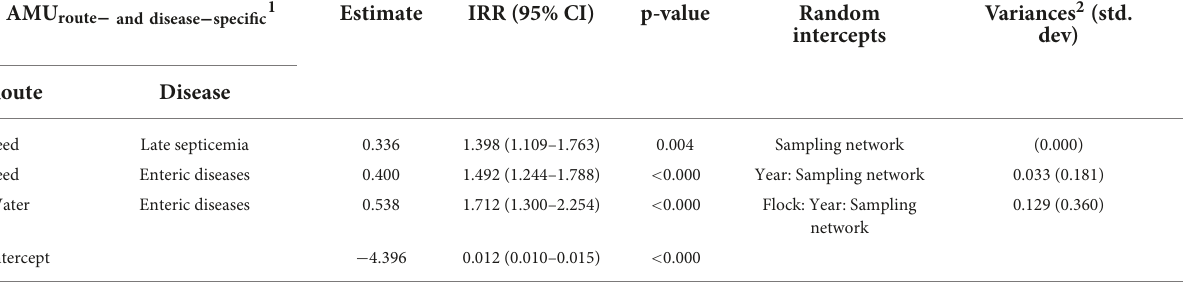
TABLE 4 Multivariable mixed-effects Poisson regression models showing associations between route and disease-specific antimicrobial use in turkey flocks ( n = 334) and resistance to the number of antimicrobial classes in E. coli isolates ( n = 1,317), 2016–2019. AMU route − and disease − specific1 Estimate IRR (95% CI) p-value Random